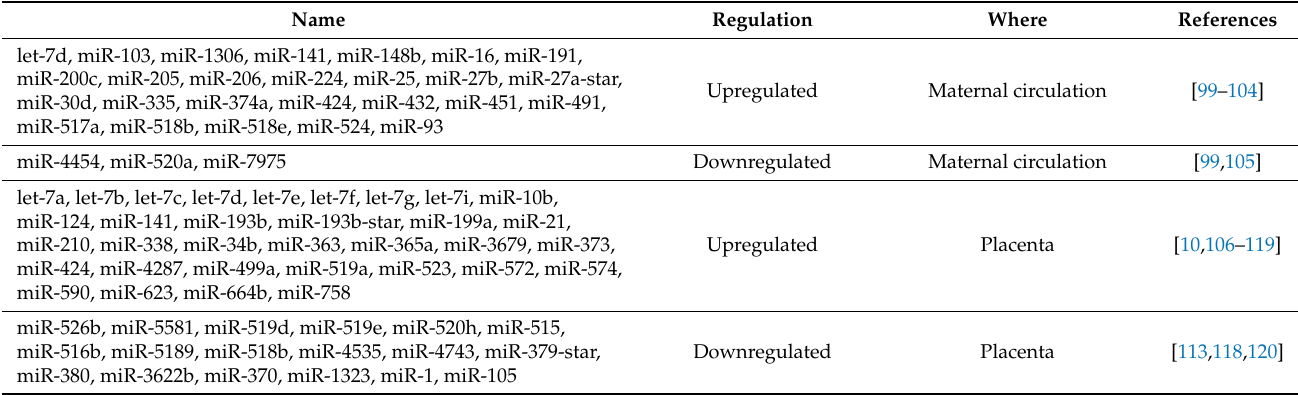
Table 2. Overview of miRNAs in intrauterine growth restriction